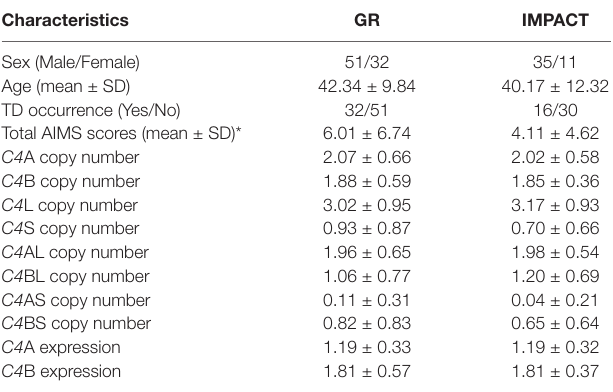
TABle 1 | Characteristics of the samples analyzed in this study. Characteristics GR